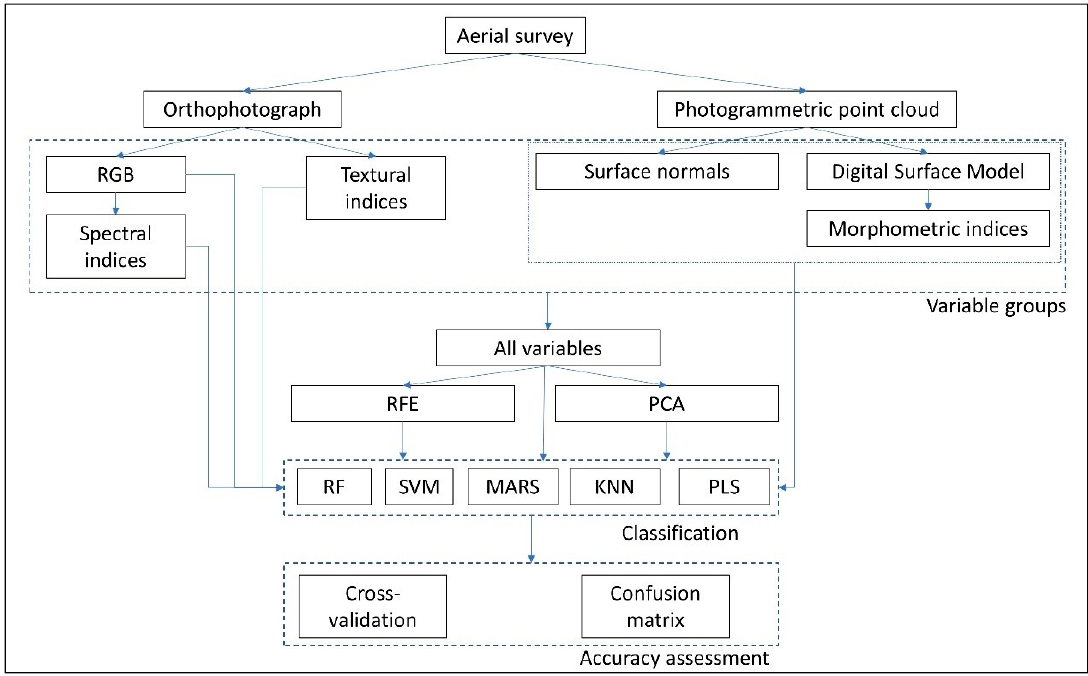
Figure 3. Variables and workflow.